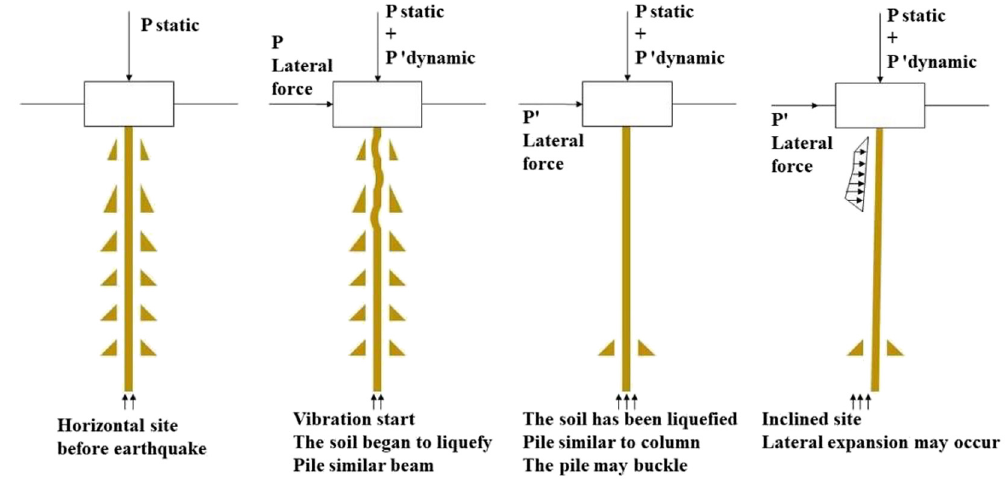
Figure 1: Schematic diagram of pile foundation failure loading time history in Bhattacharya and other liquefaction